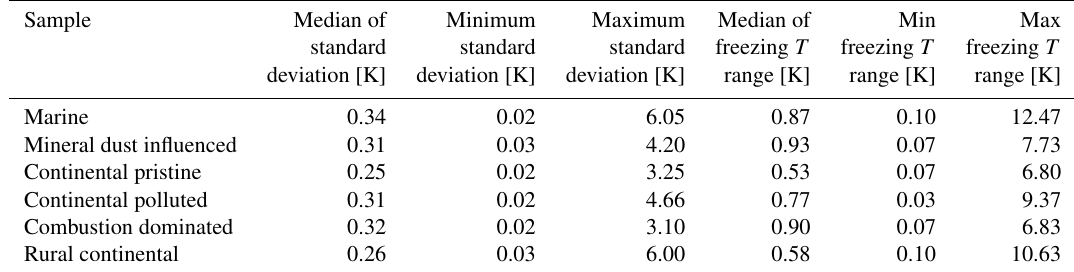
Table 2. The median of the standard deviations for four freezing cycles on each drop for the normal freezing temperature in cooling-only experiments. Also the median of the freezing temperature range (difference between highest and lowest observed freezing temperature) for the individual drops is given for all